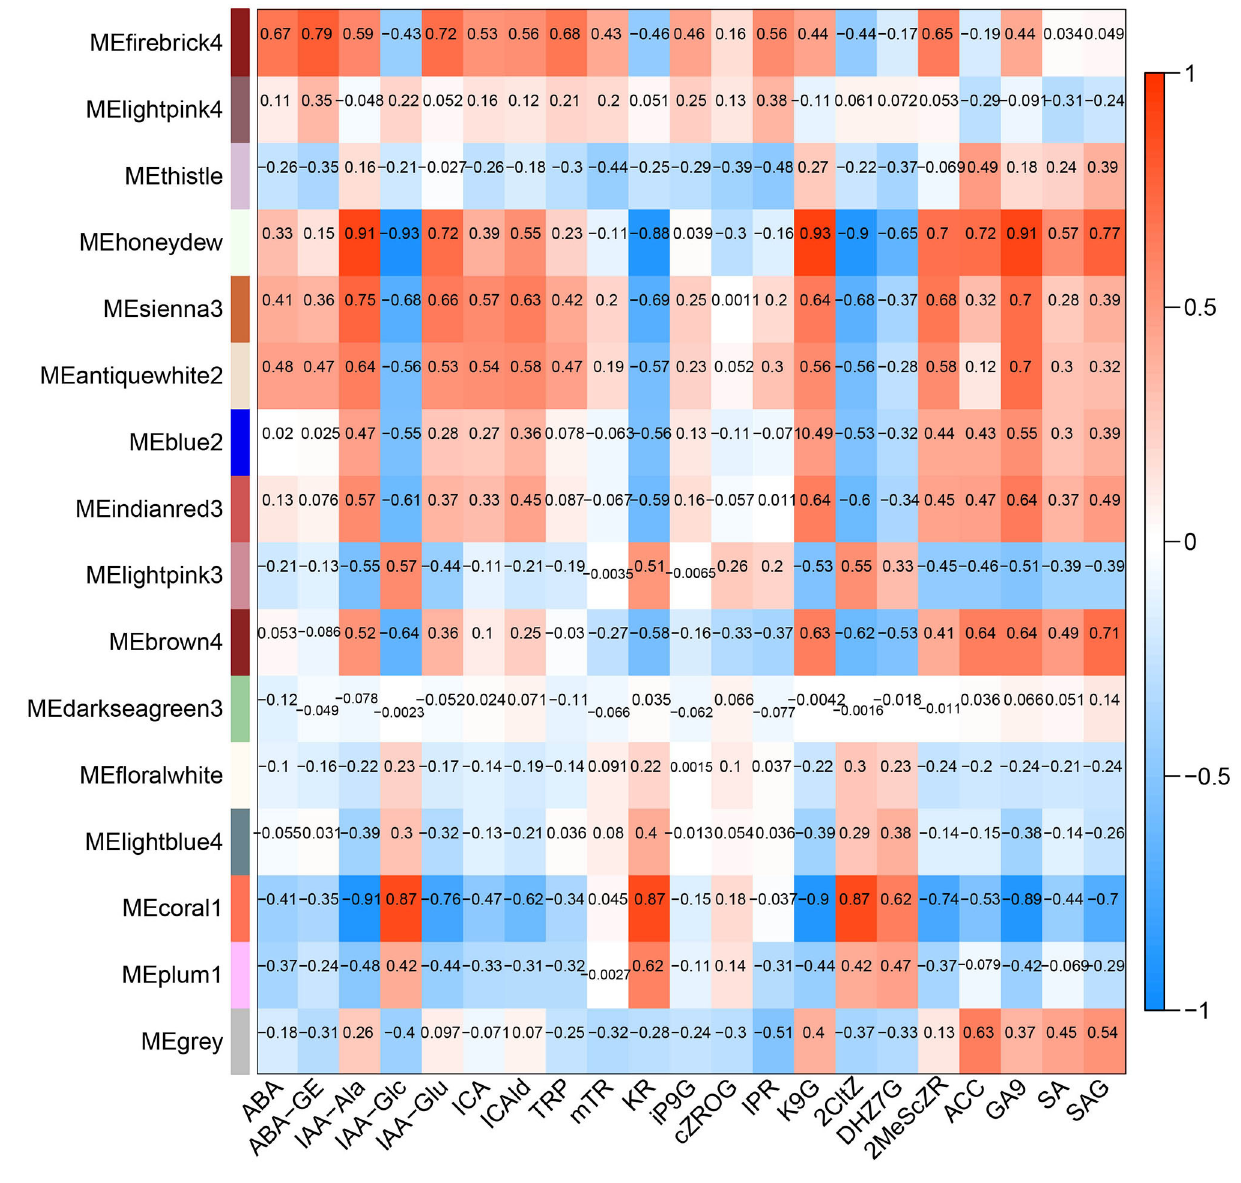
FIGURE 7 | Correlations between modules and dominating plant hormone component traits in Z. bungeanum